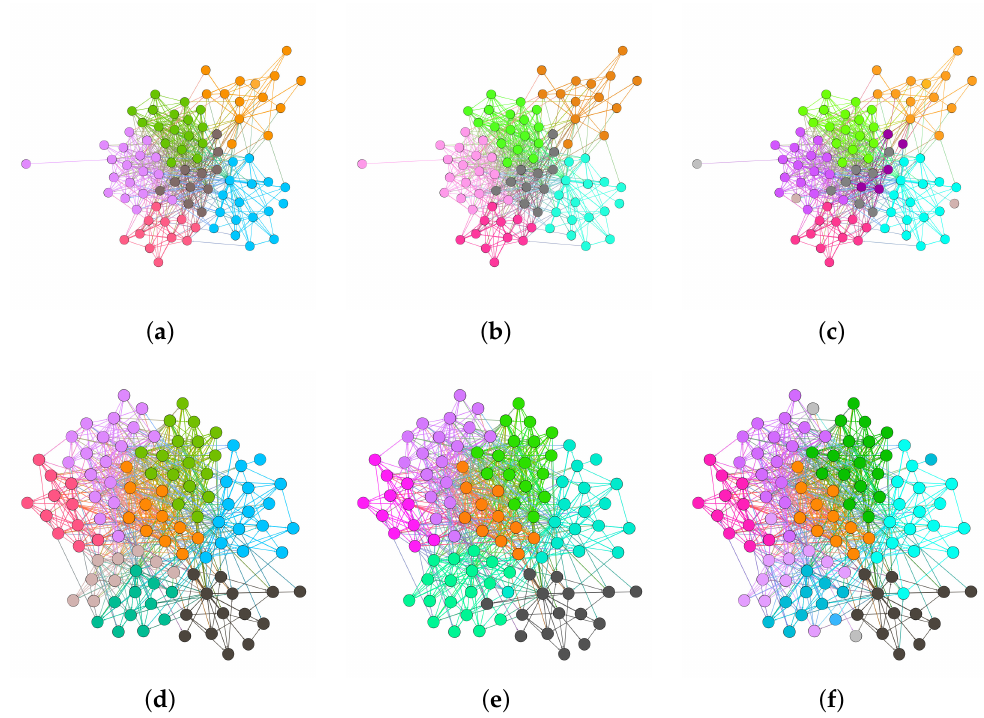
Figure 4. The nodes’ classification of Spatio-info network, where different colors represent different class: ( a – c ) Network 2; and ( d – f ) Network 3. ( a , d ) The administrative division; ( b , e ) the result of the community detection algorithm; and ( c , f ) the classification result of the MDND. This is in the form of the Spatio-info Networks, in which the nodes represent cities, the links represent the links among cities, and different colors of nodes indicate the nodes are in different